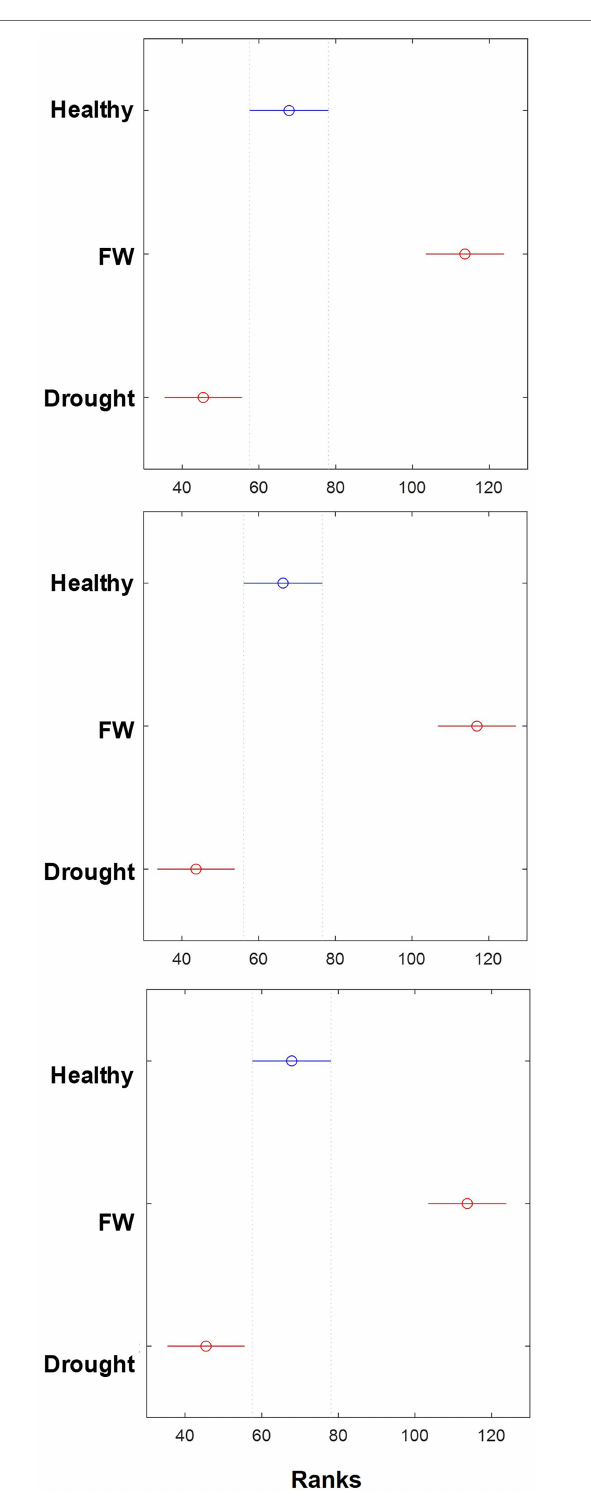
FIGURE 4 | Kruskal–Wallis plots of Raman intensity of 1,155 cm − 1 (top), 1,184 cm − 1 (center), and 1,525 cm − 1 (bottom) bands in the spectra collected from three treatment groups: uninoculated and well-watered control plants (Control group), FOC-inoculated and well-watered plants (FOC group), and uninoculated and water-deficient plants (Drought